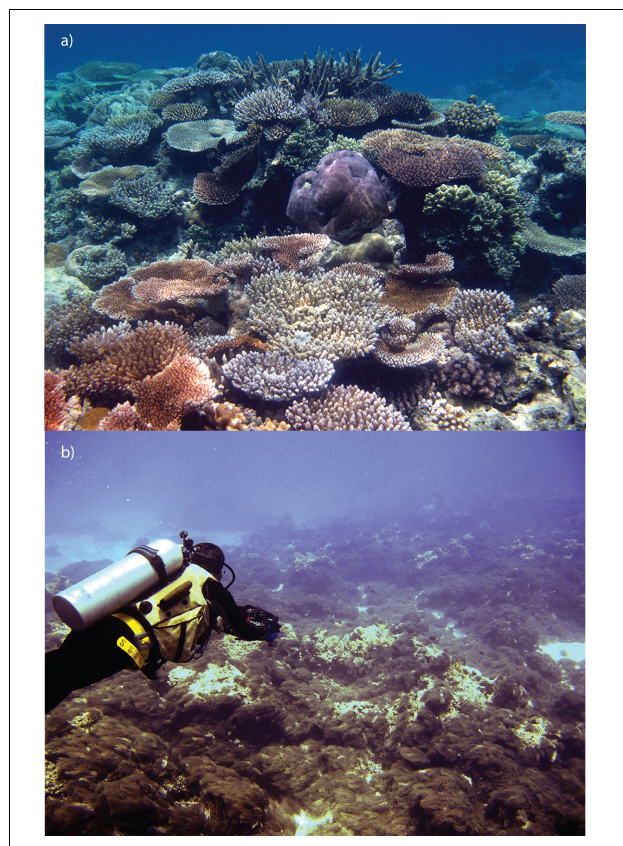
FIGURE 2 | Images showing (a) a coral-dominated reef and (b) an algal-dominated reef.